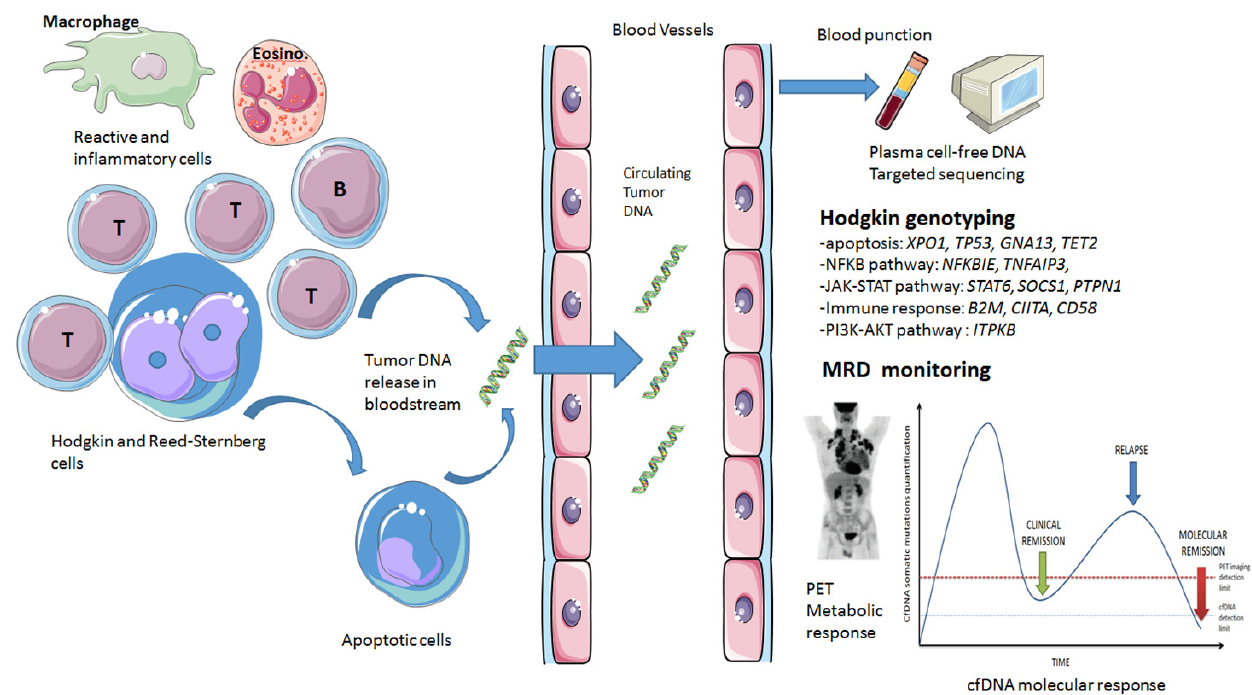
Figure 1. Schematic overview of cell-free DNA in classical Hodgkin lymphoma. Abbreviations: MRD: minimal residual disease.